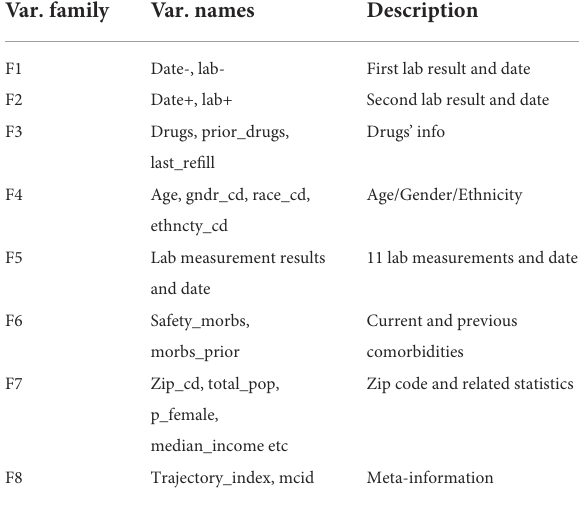
TABLE 1 Names, grouping, and descriptions of patient variables for hypertension